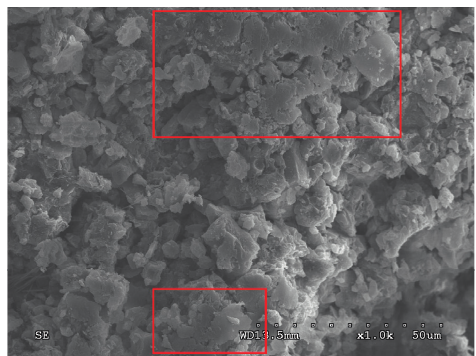
Figure 8: The soil of curing 7d and being magnified 1000 times.